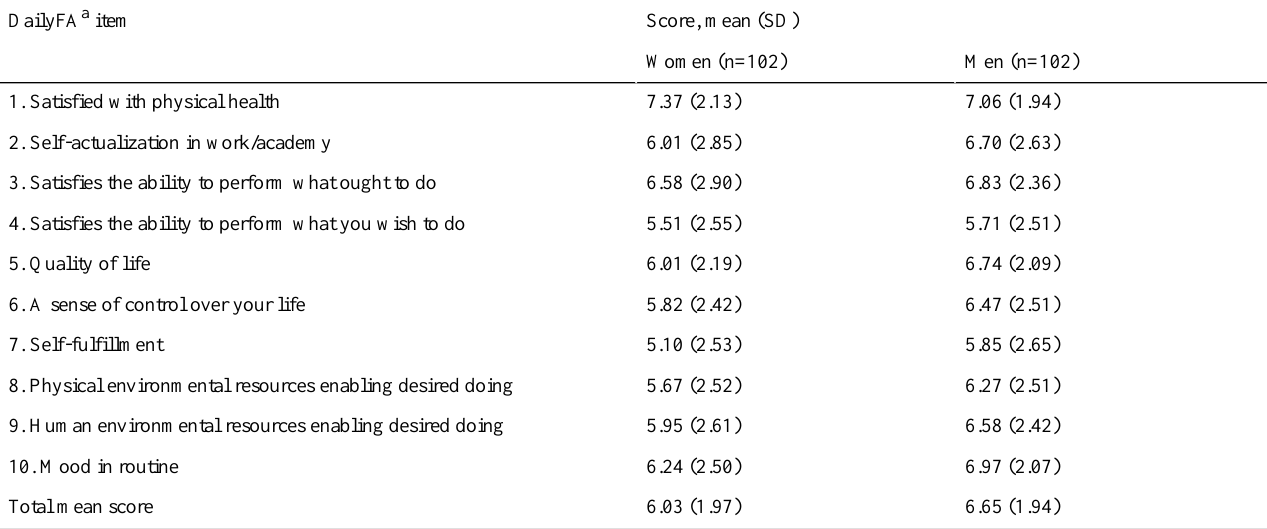
Table 2. Gender comparison of means and standard deviations of the DailyFA questionnaire items and final mean scores.